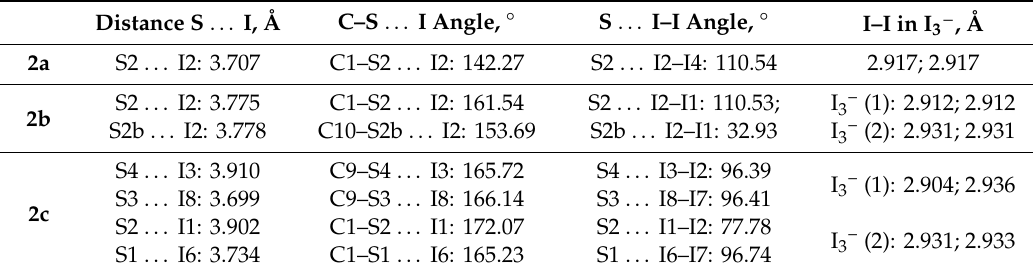
Figure 2. Crystal packing of 2a ( a ); 2b ( b ) and 2c ( c ) with thermal ellipsoids of 50% probability, view along the b crystallographic axis. Table 2. Experimental geometric parameters of S…I interactions in 2a–c crystal structures.